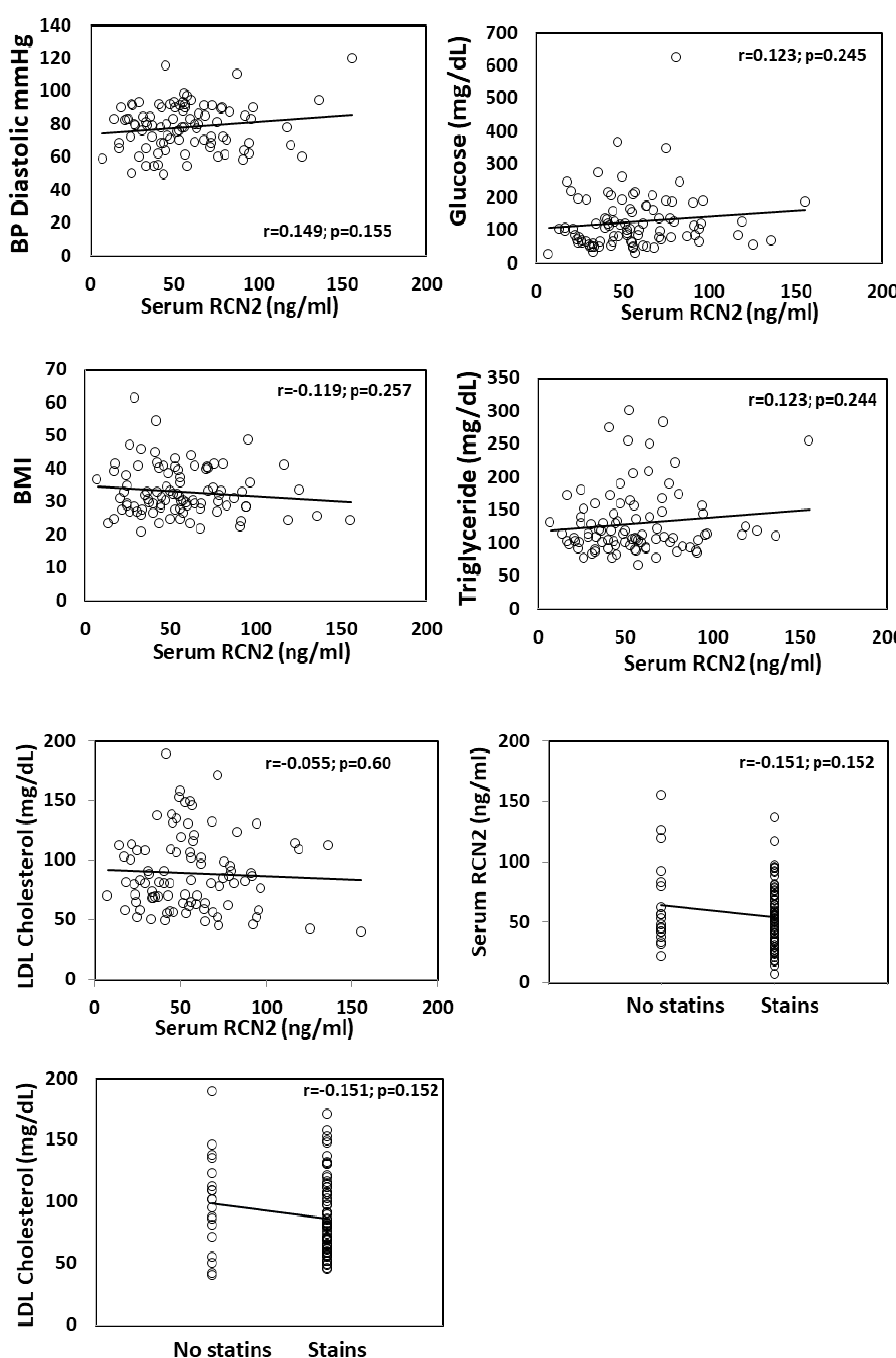
Figure 5. Associations of serum RCN2 concentrations with serum risk parameters relevant to cardiometabolic diseases in 92 patients with coronary heart disease. The regression line, p - and R-values were determined using the linear regression model. Serum RCN2 shows a significant inverse association with serum K+ and HDL cholesterol, a trend of association with WBC (white blood cells) count, Na+, triglyceride, diastolic BP (blood pressure), BMI, glucose and statin treatment, and no association with LDL. Association of hsCRP with atheroma burden, expressed as % of the maximal luminal diameter reduction, is also shown. Each dot represents an individual patient. Table 1. Regression analysis of associations of serum RCN2 concentrations with clinical and lab measures in the CAVA cohort.